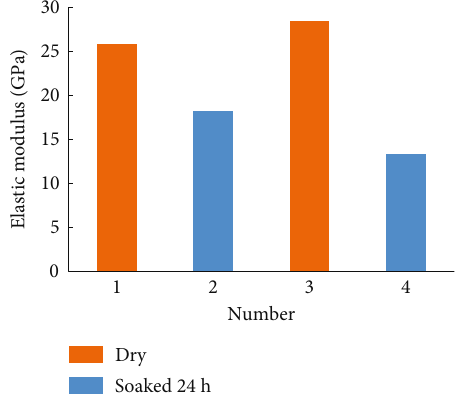
Figure 4: Changes in elastic modulus before and after soaked in water